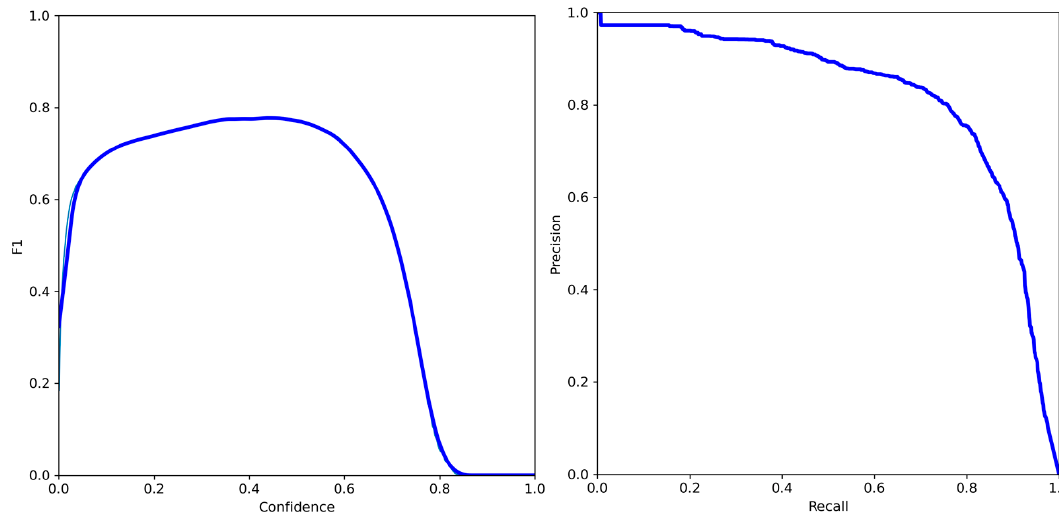
Figure 6. The F1 and PR curves.